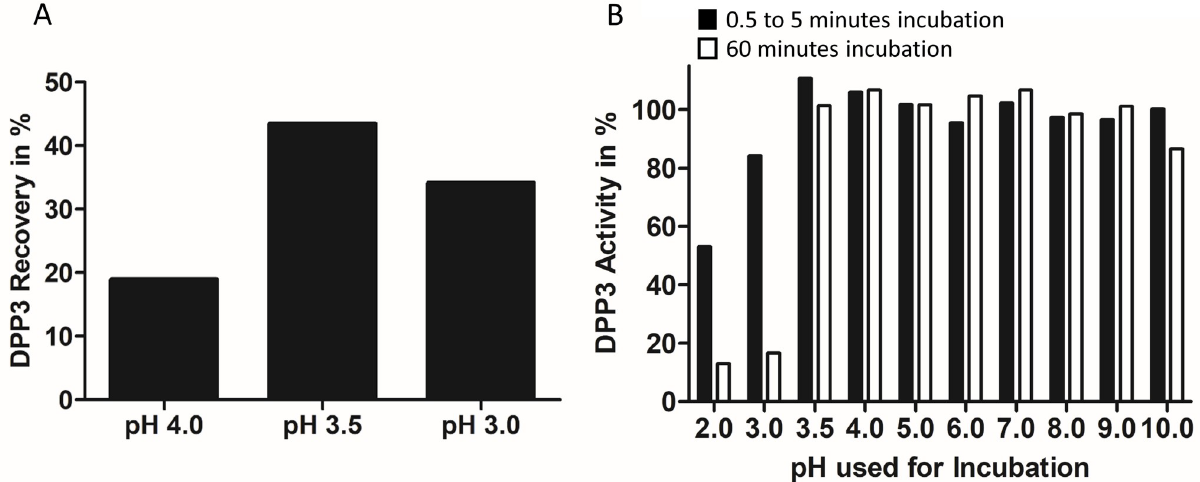
Fig 1. pH Stability of DPP3 and elution efficiency of native DPP3 at specific pH. (A) One-step elution of native DPP3 during IAP using buffers of different pH values shown in the figure. After elution, presence of DPP3 was measured via DPP3-LIA. DPP3 amount captured by the resin (Amount of DPP3 in starting material (BCL) substracted by amount of DPP3 in flow-through) was set as 100%. (B) DPP3 was incubated in buffers of different pH values as indicated in the figure. Aliquots of the incubation mixture were neutralized either after 30 seconds (pH 2.0–4.0) or after 5 minutes (pH 5.0 – pH 10.0) (black bars) and after 60 minutes of incubation (white bars). DPP3 activities were measured in DPP3-ECA. The activity of an untreated control (DPP3 in storage buffer, pH 7.4) was set as